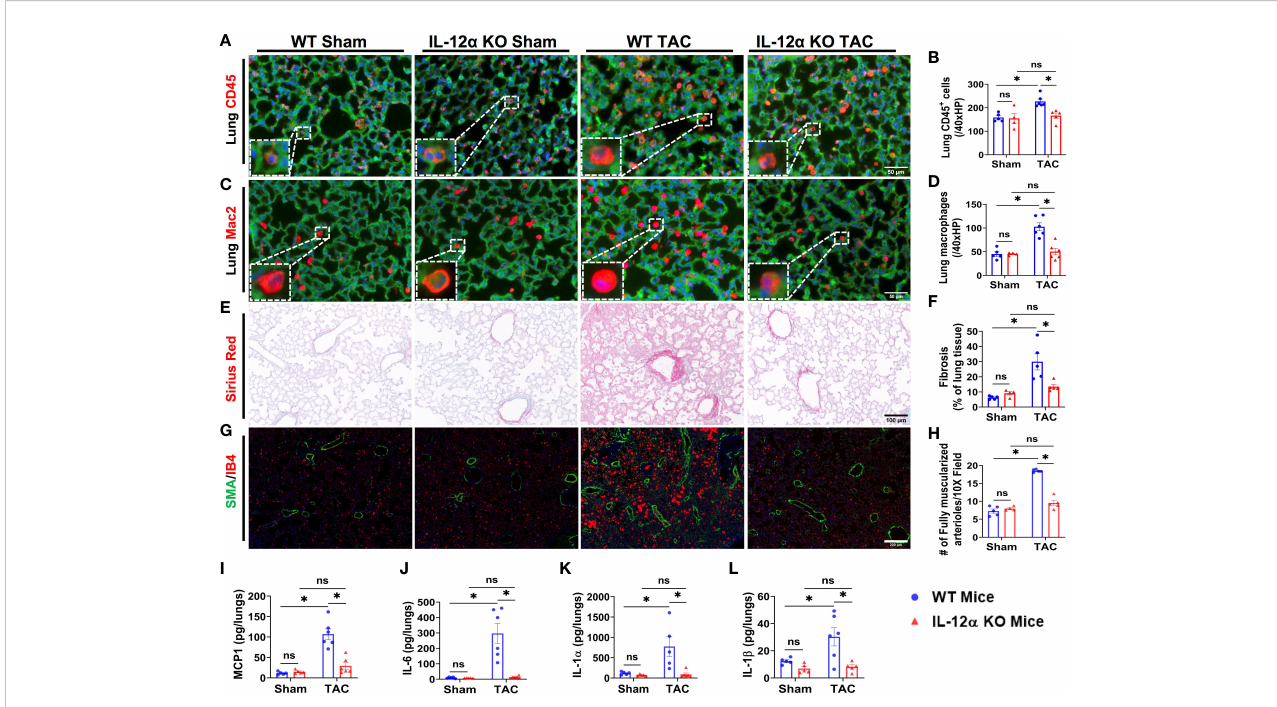
FIGURE 3 IL-12 a KO signi fi cantly attenuated TAC-induced pulmonary in fl ammation, fi brosis, and vessel remodeling. (A – D) Representative images and quanti fi ed data of in fi ltrating leukocytes or macrophages in the lung performed by immuno-histological staining. (E, F) Representative images and quanti fi ed data of lung fi brosis performed by Sirius red/Fast green staining. (G, H) Representative images and quanti fi ed data of pulmonary vessel remodeling performed by immuno-histological staining. (I – L) Alterations of MCP1, IL-6, IL-1 a , and IL-1 b per lungs sample. *p<0.05; ns, non-signi fi